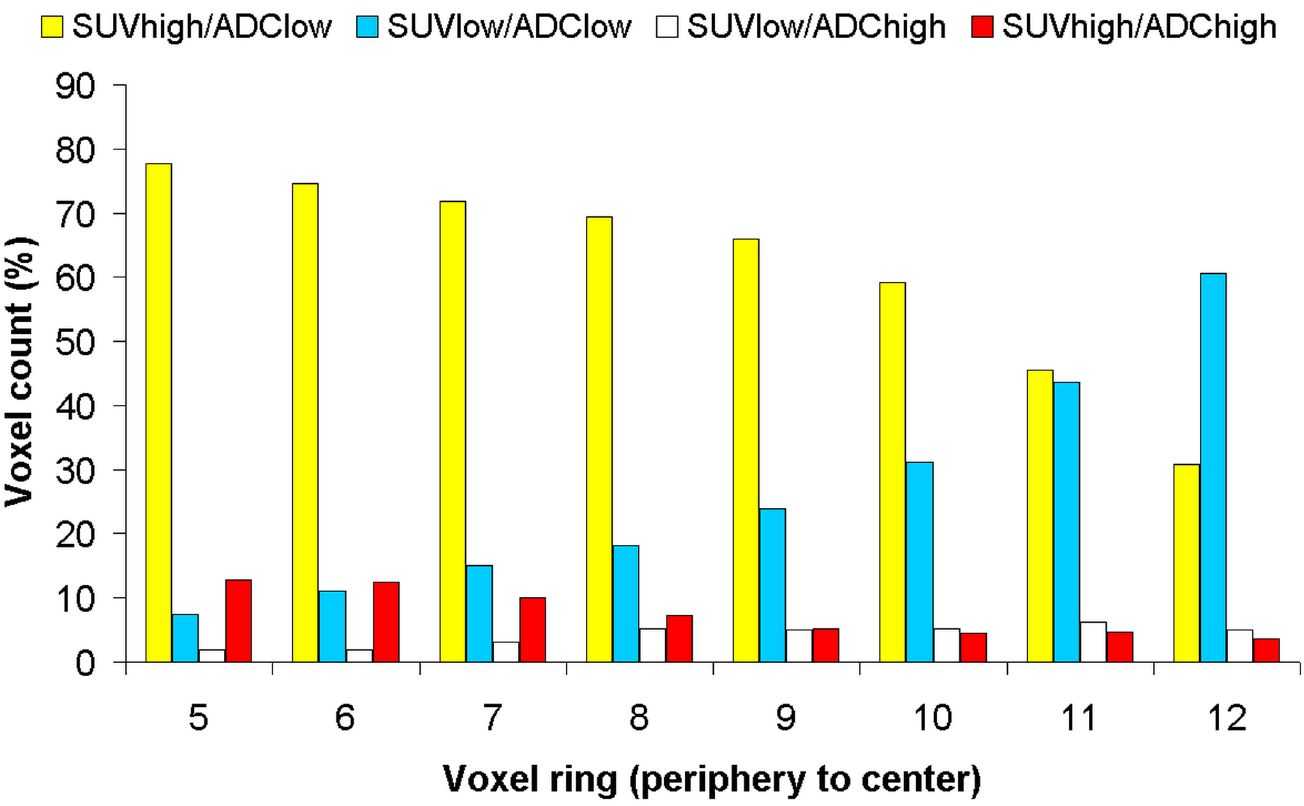
Fig 6. Using a threshold for low and high tracer uptake of SUV = 3.6 for 18 F-FDG and ADC = 1.5x10 -3 mm²/s for restricted and less restricted water diffusivity, up to four tumor cluster of different biologically activity could be defined. Here, the relative distribution (%) of the different cluster from the tumor periphery to the center is shown. The relative number of voxels with high uptake of 18 F-FDG and lower ADC values (yellow, vital tumor) decreases to the tumor center, oppositely for voxels with low uptake of 18 F-FDG and lower ADC values (turquoise, high density of cells with low tumor activity or low density of tumor cells but dense tumor stroma caused by desmoplastic reactions). Voxels from the clusters with less restricted water diffusivity (SUV high respectively SUV low ) can be found in all tumor parts, indicative either for hypoxia (SUV high , red) or necrosis (SUV low , white). However, the highest amount of voxels from the SUV high /ADC high cluster can be found within the transitional zone, whereas the voxel of the SUV low /ADC high cluster increase to central tumor parts.